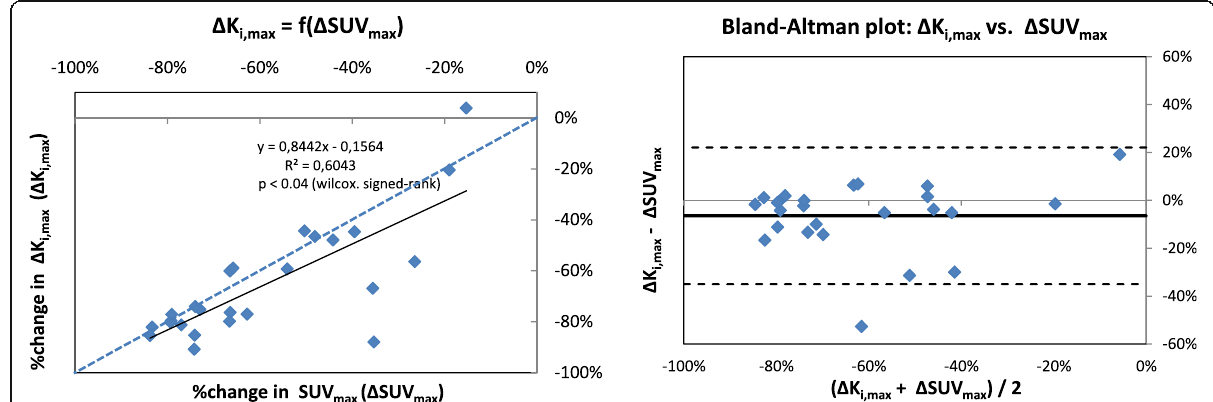
Fig. 9 Regression line and Bland-Altman plots between the ParaPET Δ K i,max value and Δ SUV max values. For each lesion, K i,max and SUV max were measured at the same voxel position. On the regression graph, the dashed line is the line of equality. On the Bland-Altman plots, the mean difference and the 1.96 SD limits are represented by the solid and the dashed lines